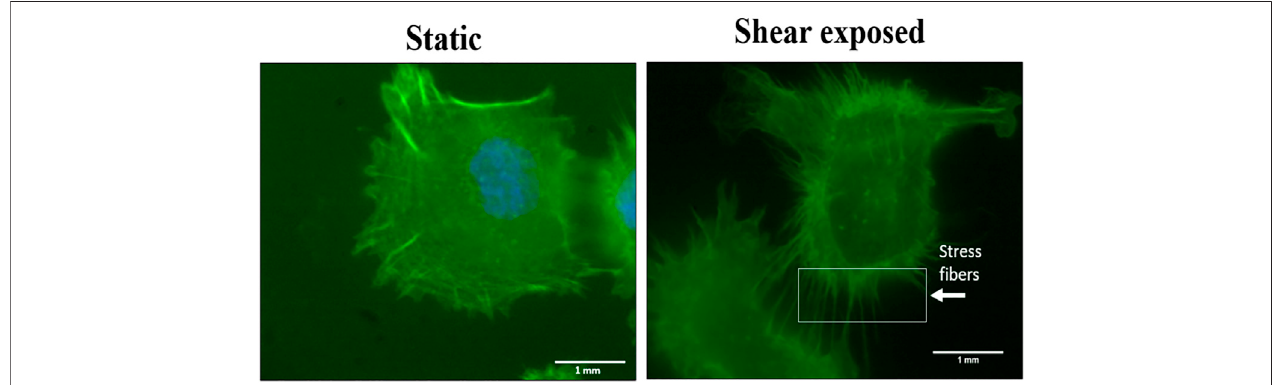
FIGURE9| CytoskeletalstainingforMDA-231cellsunderstaticand fl uid fl owconditions.Actin fi lamentsstress fi bersformationafterbeingexposedtoshearstress at a low shear rate for 8 h.